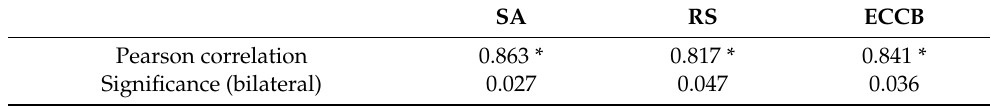
Table 5. Correlation analysis (EO concentration and inhibition zone